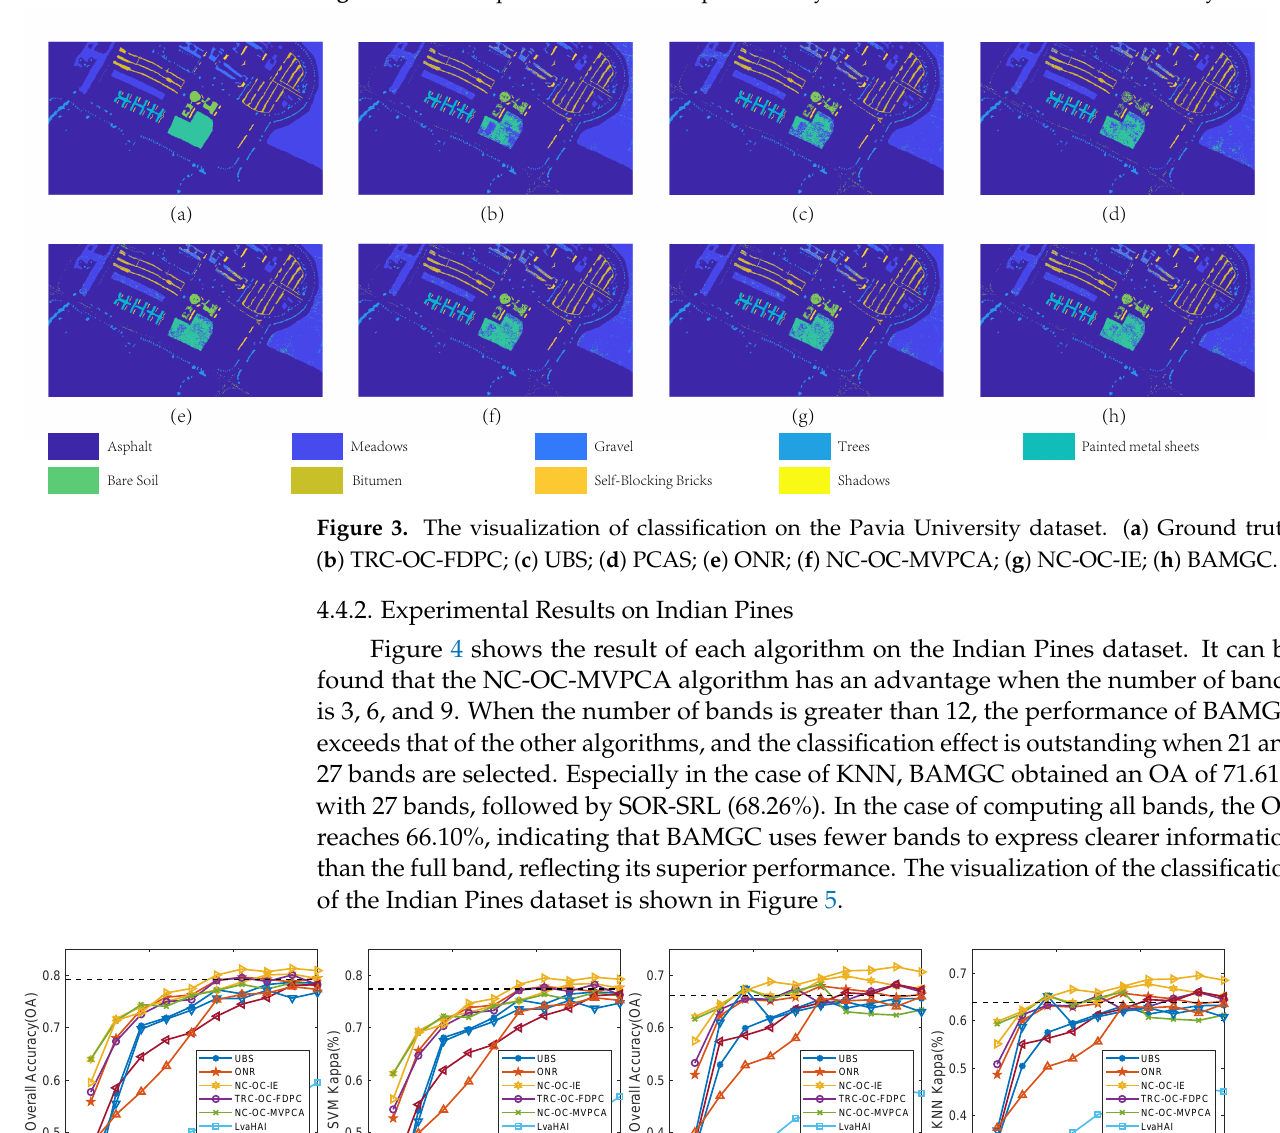
Figure 2. The comparison of OA and κ produced by SVM and KNN on the Pavia University dataset.